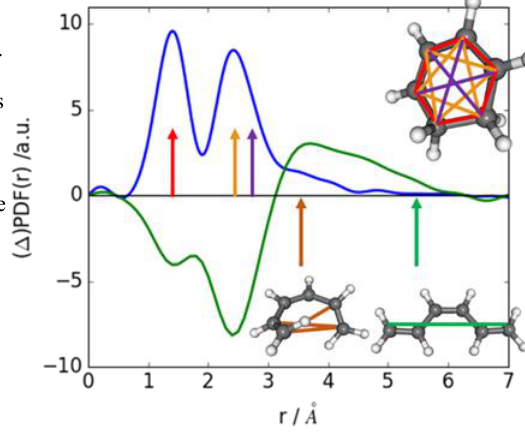
Fig. 1. Static pair distribution function (PDF) of 1,3-cyclohexadiene (CHD, blue). The two maxima in the PDF can be associated with carbon-carbon distances as color-coded in the inset and marked by arrows. A representative difference PDF (ΔPDF) 0.7 ps after photoexcitation (green) shows negative contributions at the peak positions of the static PDF due to ground state population loss. It exhibits positive amplitudes from the photoexcited population, in a distance range, where CHD has negligible contributions. Comparison with carbon-carbon distances in two isomers of the photoproduct 1,3,5- hexatriene (inset) shows good